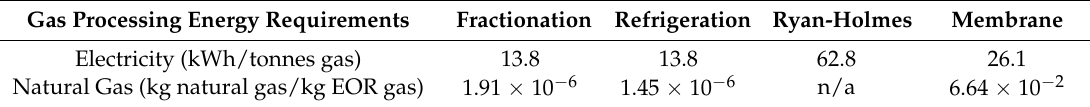
Table 2. Utility requirements for gas separation processes. Modified from